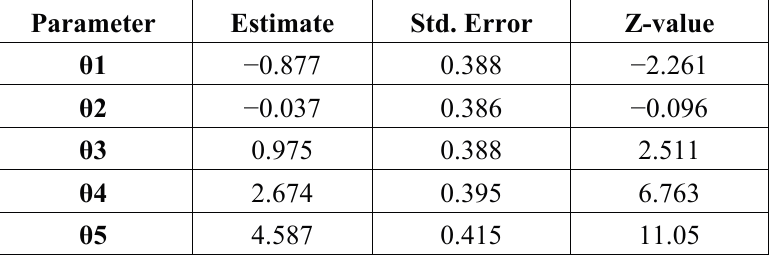
Table 3. Threshold Parameter